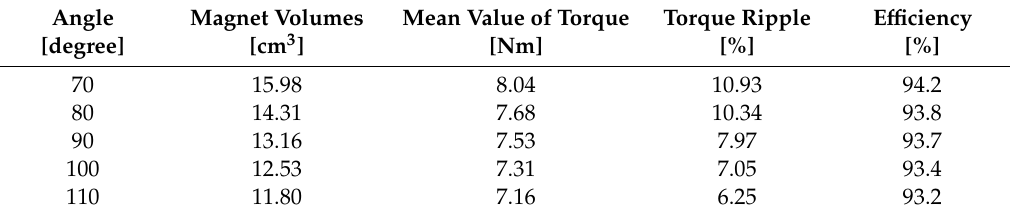
Figure 12. Mean value of torque, torque ripple, and efficiency with magnet volume. Table 3. Magnet volumes and resulting performances under load.